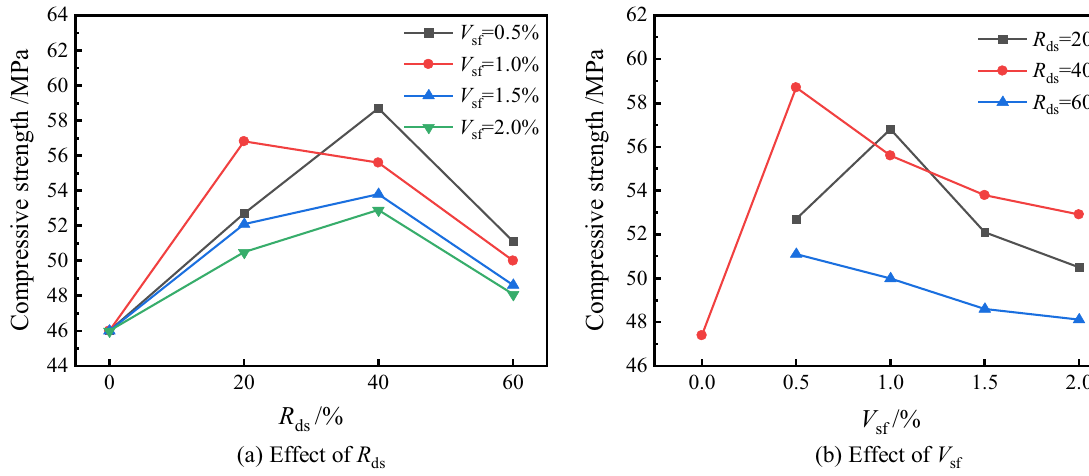
Figure 5. Effect of different R ds and V sf on compressive strength.